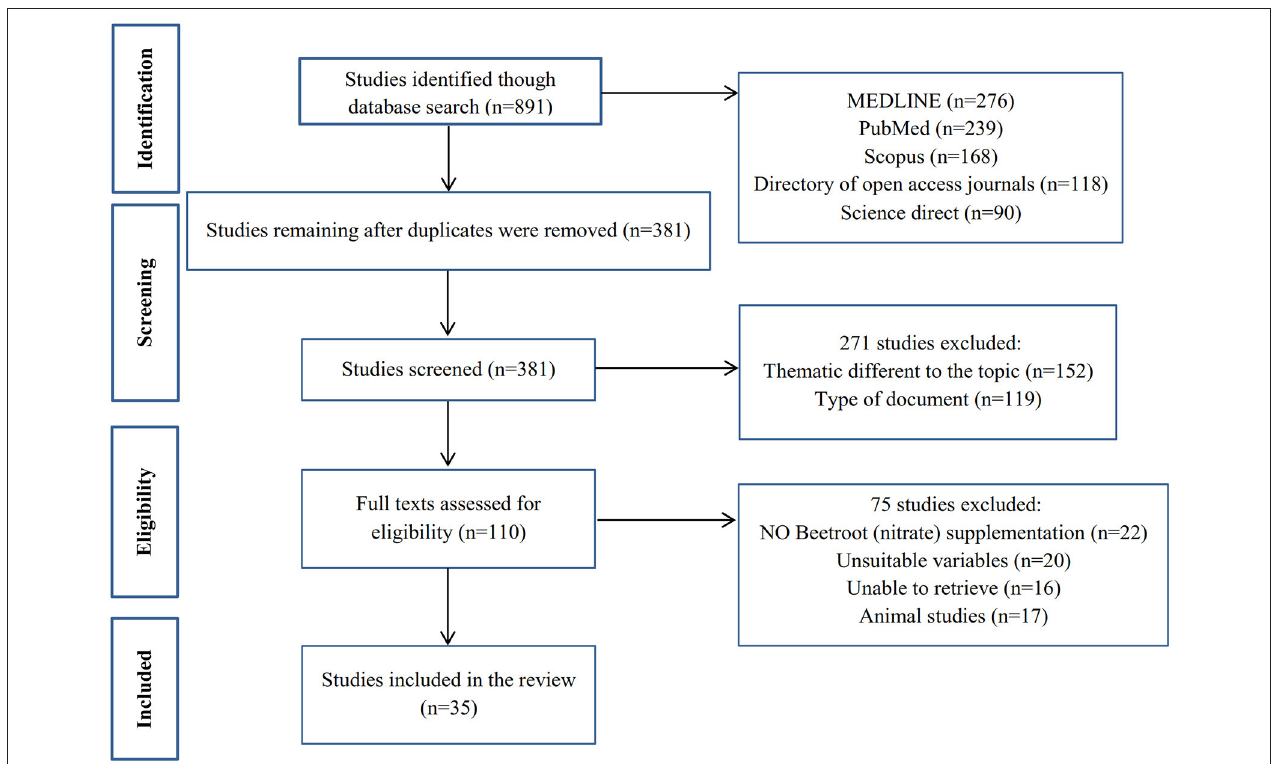
FIGURE 2 | Flow chart of the methodology for the search